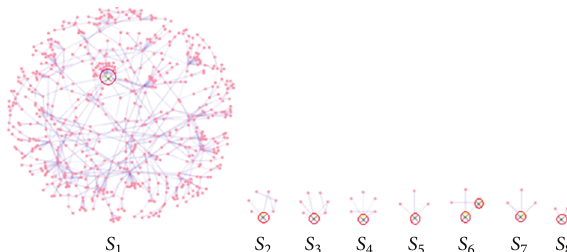
Figure 1: The eight subnetworks for any training set 𝑑 . In each subnetwork, the symbol “ ⨂ ” shows the hub-gene/s, which has the highest number of interactions among other genes. In subnetwork 𝑆 6 , two hub-genes are identified, as they both have the maximal and equal number of interactions; that is, each gene has 2